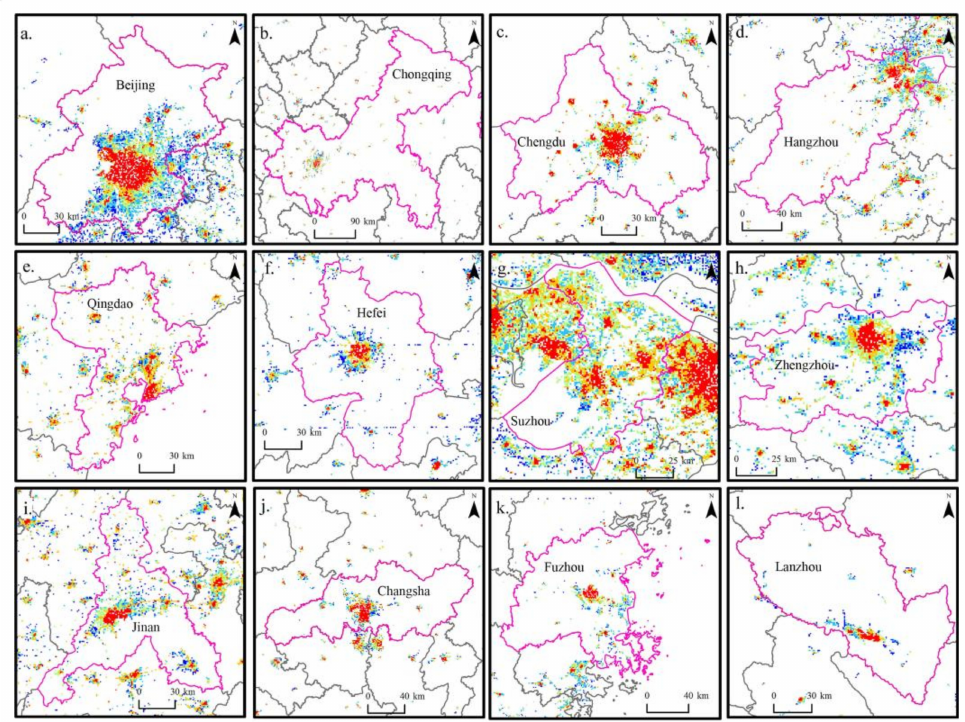
Figure 4. Spatial distribution of UVI of some cities on grid scale: ( a ) Beijing City, ( b ) Chongqing City, ( c ) Chengdu City, ( d ) Hangzhou City, ( e ) Qingdao City, ( f ) Hefei City, ( g ) Suzhou City, ( h ) Zhengzhou City, ( i ) Jinan City, ( j ) Changsha City, ( k ) Fuzhou City, and ( l ) Lanzhou